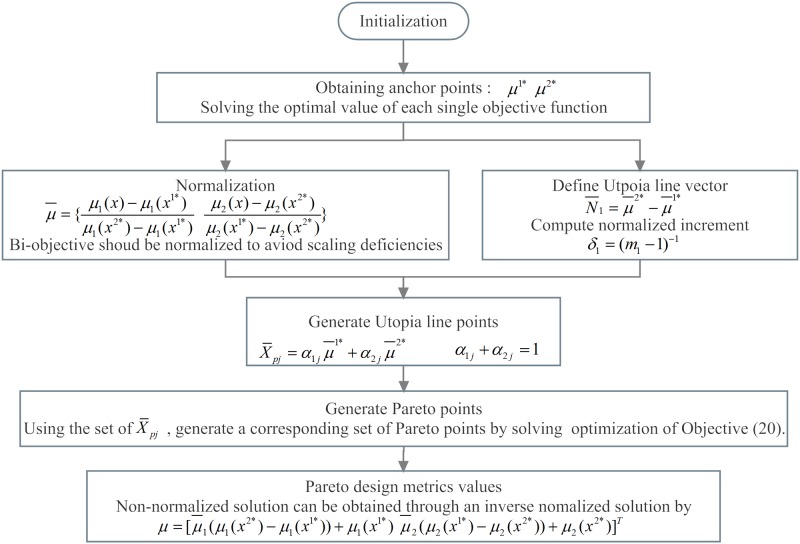
Solution procedure of NNC method.